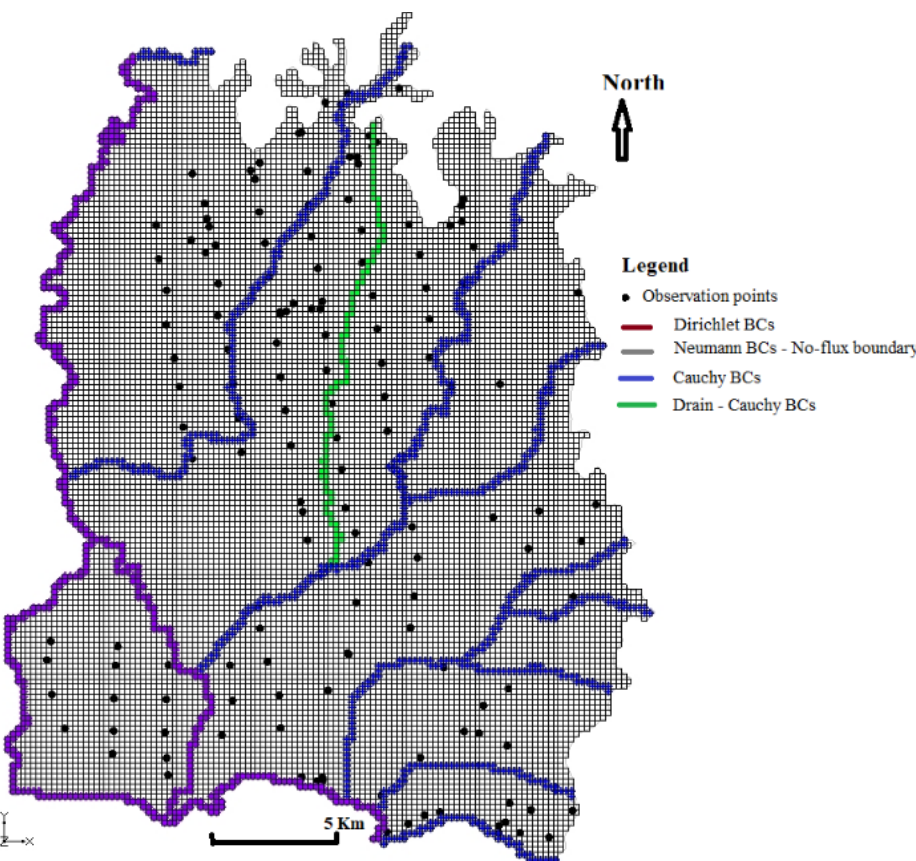
Figure 7. Boundary conditions and model discretization. Table 4. Hydraulic conductivity values assigned to model